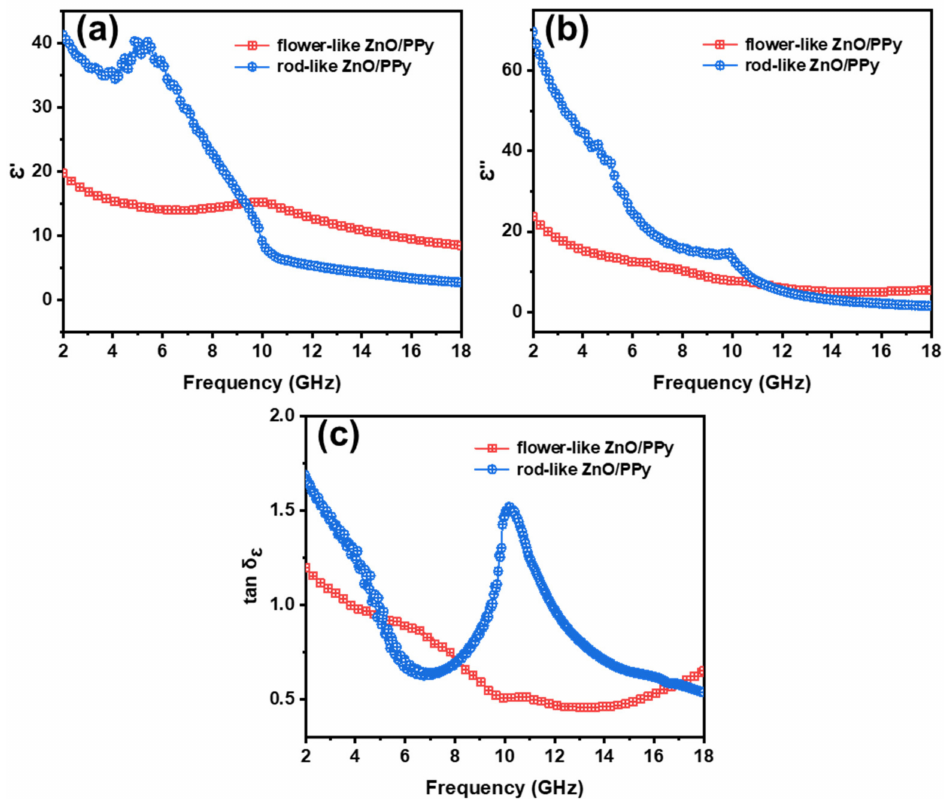
Figure 5. Frequency dependence of ( a ) real and ( b ) imaginary parts of complex permittivity; ( c ) di- electric loss tangent of flower-like ZnO/PPy and rod-like ZnO/PPy